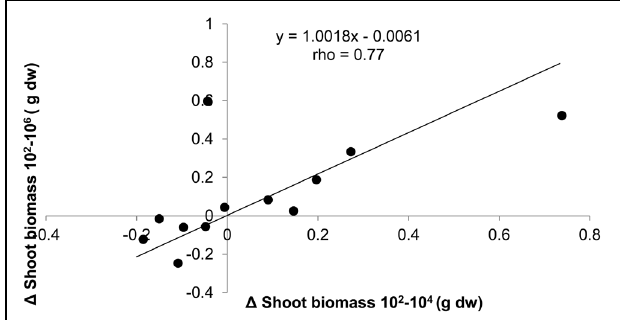
FIGURE 3 | The absolute differences in shoot biomass of T. aestivum between dilution treatments plotted against each other for each of the 12 soil origins. Spearman rank correlation test n = 12, P =